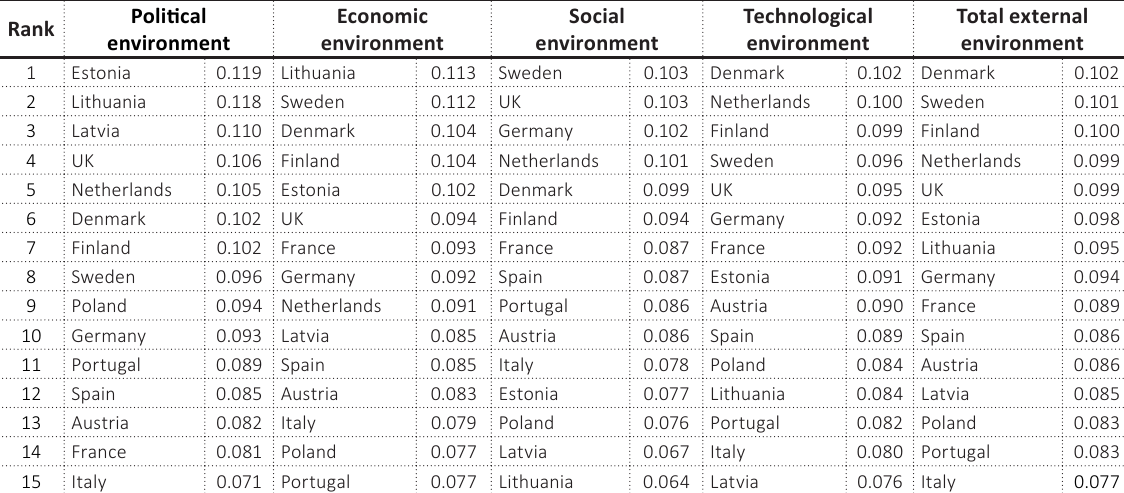
Source: Authors’ elaboration.